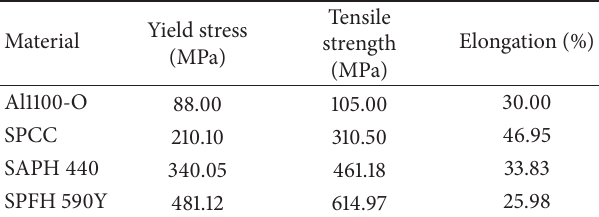
Table 2: Mechanical properties of workpiece material.